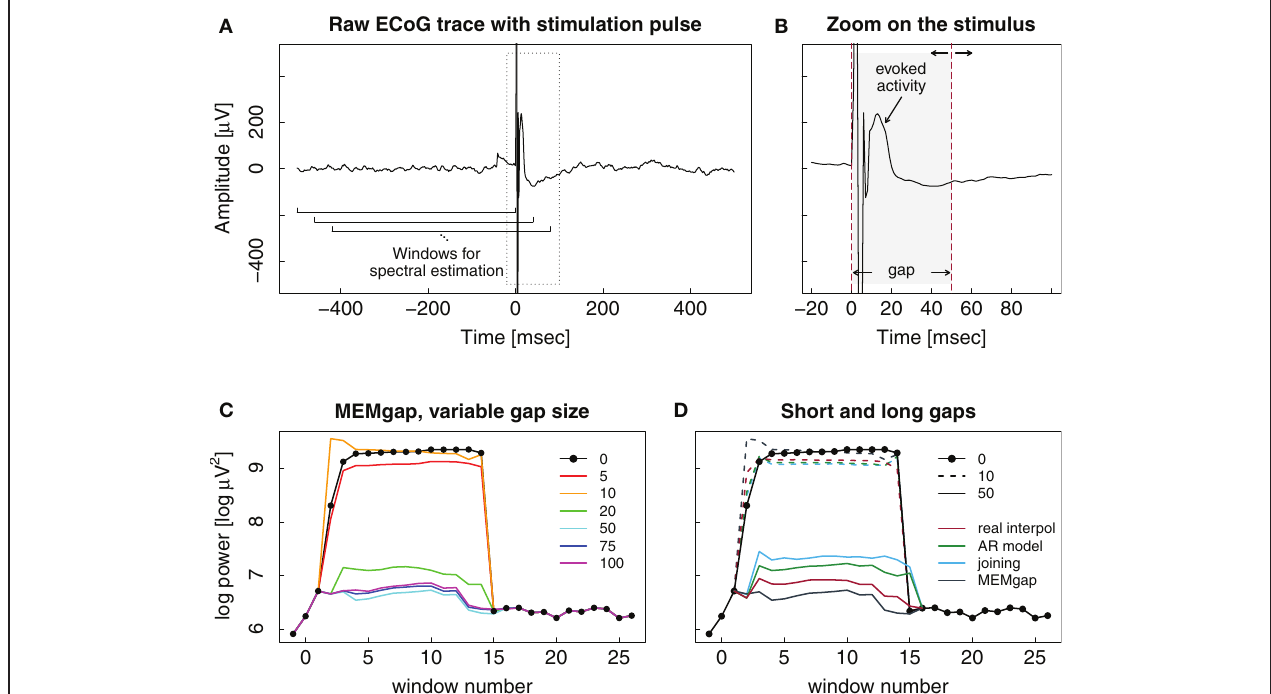
FIGURE 6 | Example ECoG trace of an epidural stimulation event. (A) One second of data with the stimulation at time point 0. The brackets show the moving window used for spectral analysis. (B) Zoomed version of the left plot, showing the evoked activity and the stimulation artefact in greater detail. Dashed lines show the start and end markings of the gap, here with a length of 50ms. The end point of the gap can be varied in time. (C) Output of the spectral estimation using MEMgap for gap sizes of 5, 10, 20, 50, 75, and 100ms and the frequency bin centered at 21Hz. The logarithm of the estimated power is shown because of the large